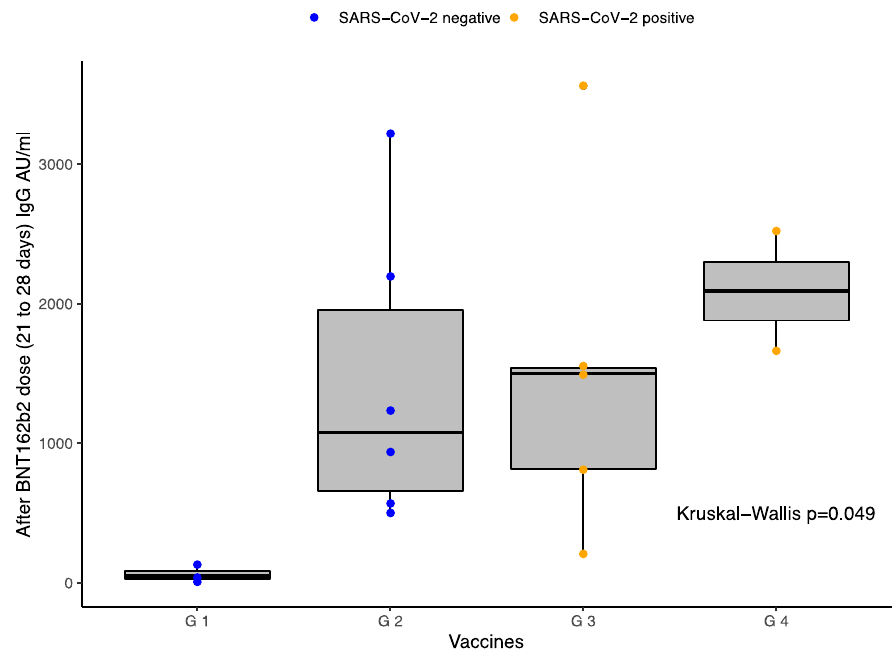
Figure 1. Anti-SARS-CoV-2 spike 1–2 IgG antibodies titers compared between groups. The boxplot in Figure 1 represents the IgG antibodies titers between the four different groups 21–28 days after BNT162b2 dose (about 4 months after first dose of Ad5-nCoV): G1 patients vaccinated with Ad5-nCoV with no known history of SARS-CoV-2 infection, G2 patients vaccinated with Ad5-nCoV and the first dose of BNT162b2 with no known history of SARS-CoV-2 infection, G3 patients vaccinated with Ad5-nCoV with a known history of SARS-CoV-2 infection, and G4 patients vaccinated with Ad5-nCoV and the first dose of BNT162b2 with a known history of SARS-CoV-2 infection. The boxplot shows the 25th, 50th, and 75th percentiles of antibody levels. The Kruskal–Wallis test was applied for comparisons showing a p -value = 0.049. The image shows statistical differences be- tween all groups. Volunteers exposed to BNT162b2 after Ad5-nCoV have higher levels of IgG S1/S2 than those that did not receive the boost. Additionally, patients previously ex- posed to SARS-CoV-2 infection had higher antibody titers. The highest level of antibody levels was G4. Blue dots represent negative history of SARS-CoV-2 infection. Yellow dots represent positive history of SARS-CoV-2 infection. The most common AEFI related to AD5-nCoV were headache ( n = 10, 83.3%), pain at the injection site ( n = 8, 66.7%), and fatigue ( n = 7, 58.3%), and their severity was classified as very low ( n = 7, 58.3%). The most common AEFI reported after the BNT162b2 dose were pain at the puncture site ( n = 5, 83.3%) and fatigue ( n = 3, 50.0%), and their severity was classified as low ( n = 3, 50.0%). Table 3 shows the AEFI related to the first dose of Ad5- nCoV and the BNT162b2 booster as reported by the participants at the time of the S3 and S4.